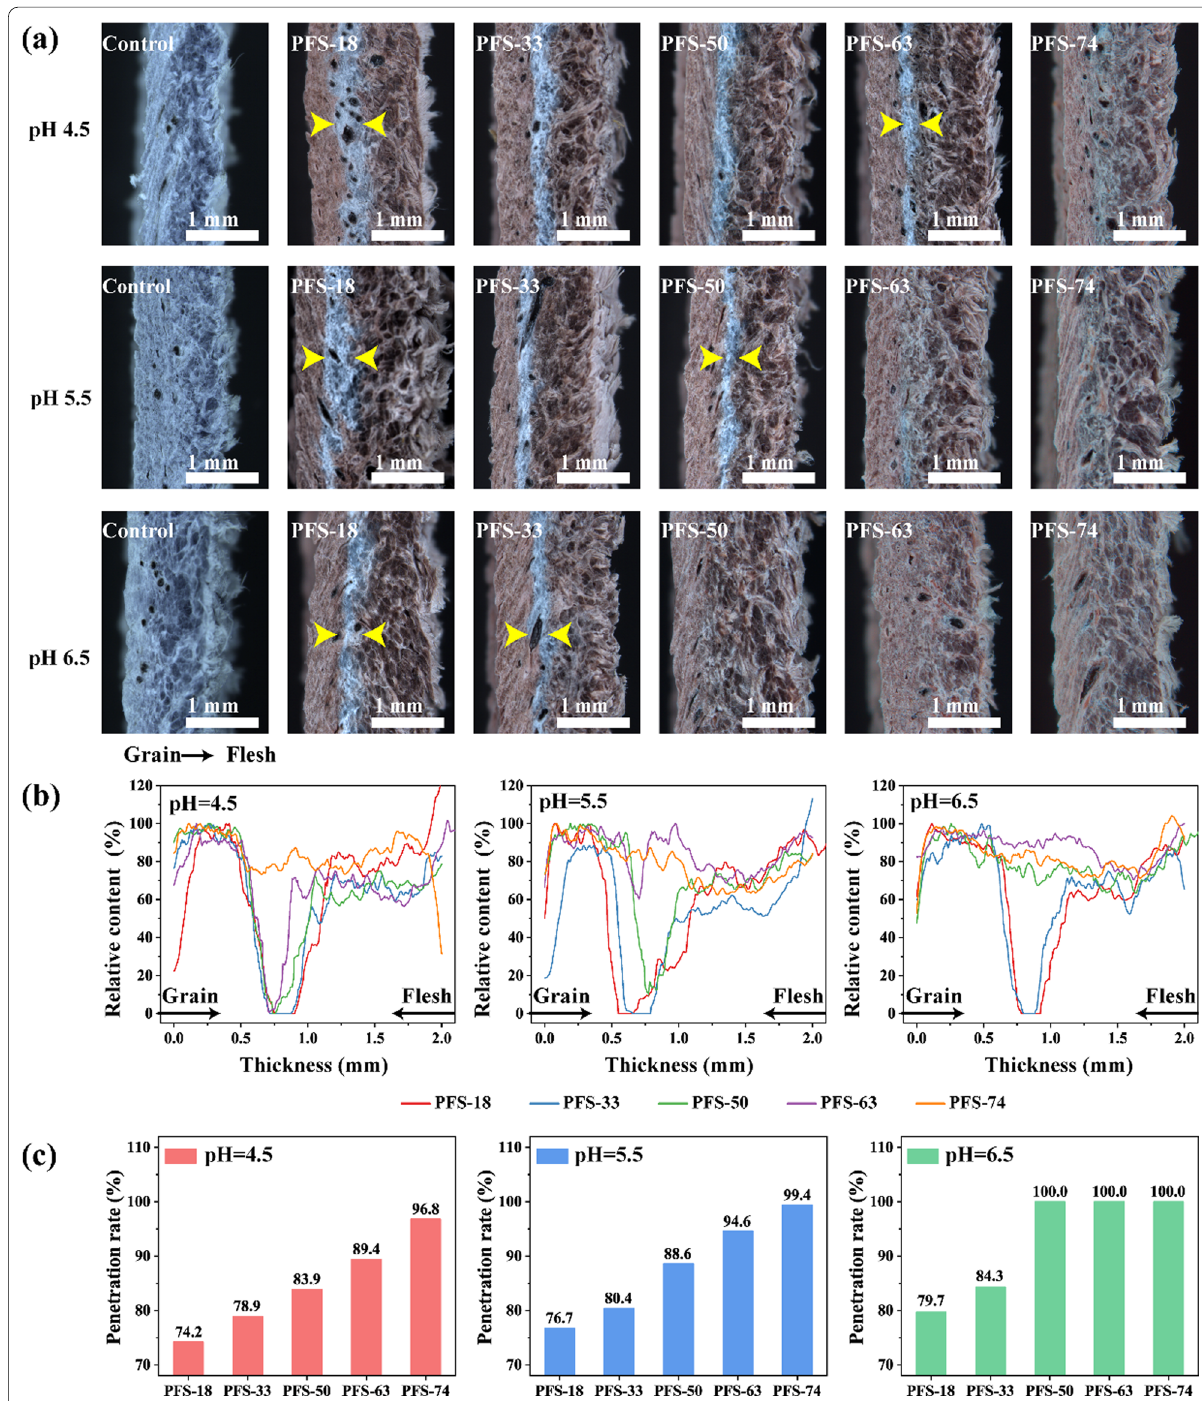
Fig. 6 a Micrographs of vertical sections of PFS retanned leather samples (scale bar, 1 mm); b relative contents of PFS in retanned leather; c penetration rates of PFS in retanned